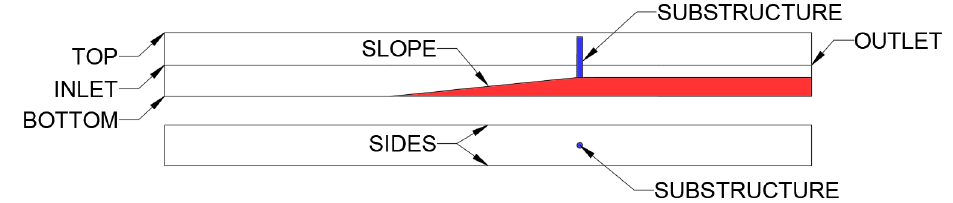
Figure 4. Numerical Wave Tank Boundaries.